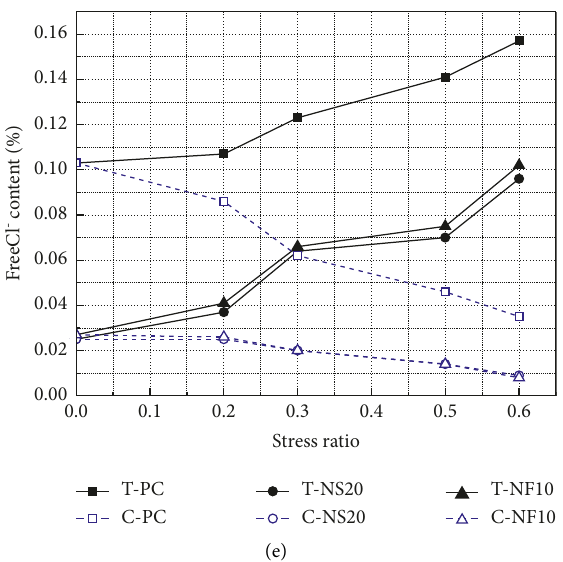
Figure 11: Comparison between tensile and compressive zones: (a) 4d, (b) 7d, (c) 14d, (d) 21 d, and (e)